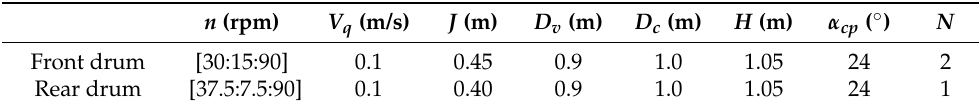
Table 2. The kinematic and geometric parameters.